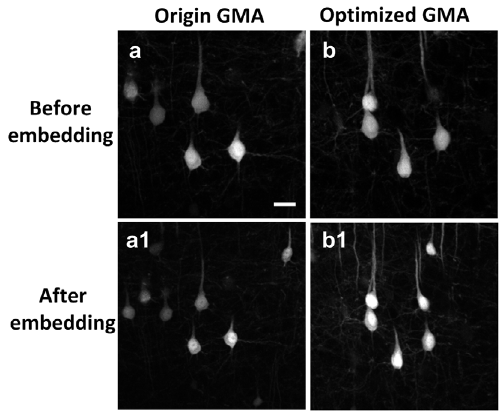
Figure 1. Fluorescence intensity of neurons is improved with optimized GMA resin. Brain sections imaged with two-photon microscopy using the same parameter settings before (a, b) and after embedding (a 1, b 1). Scale bar, 20 m m. Each image is a max-projection of the image stacks of the brain slice (thickness: 20 m m).